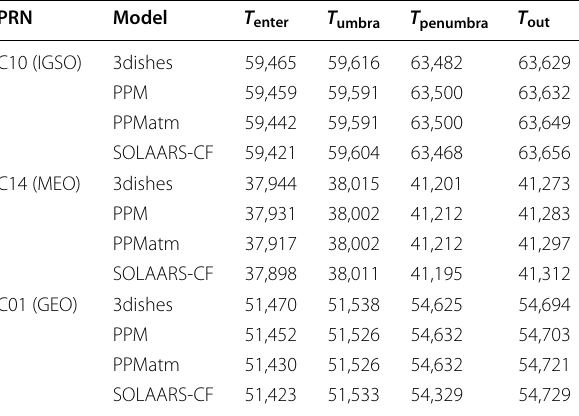
Table 3 Time the satellite enters and exits the shadow (unit: